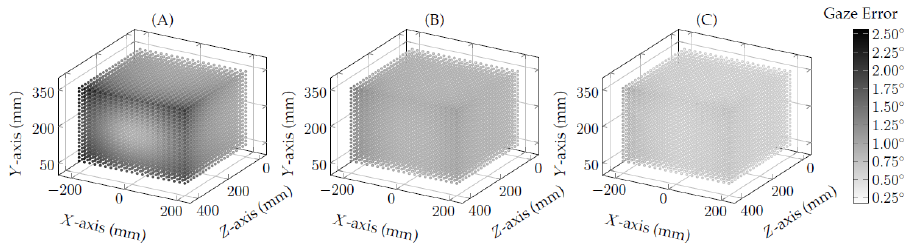
Figure 10. A three-dimensional overview of the eye-camera location’s influence on the homography- based gaze estimation methods. Each dot represents an eye-camera location in the three-dimensional space, and each scatter plot represents a set of 9261 eye-camera locations. ( A ) shows the gaze errors achieved by the traditional homography-based method, which presents the highest gaze error (2.56 ◦ ) in the simulated study at location X = − 200 mm, Y = 350 mm, and Z = 400 mm, ( B ) illustrates the improvements achieved with the eye-camera location compensation method, and ( C ) presents the results of the eye feature distribution undistortion method, which achieves the best gaze estimation accuracy (0.18 ◦ ) at location X = 0 mm, Y = 200 mm and Z = [ 0 mm ,400 mm ] . The scatter plot represents each eye-camera location in the world coordinate